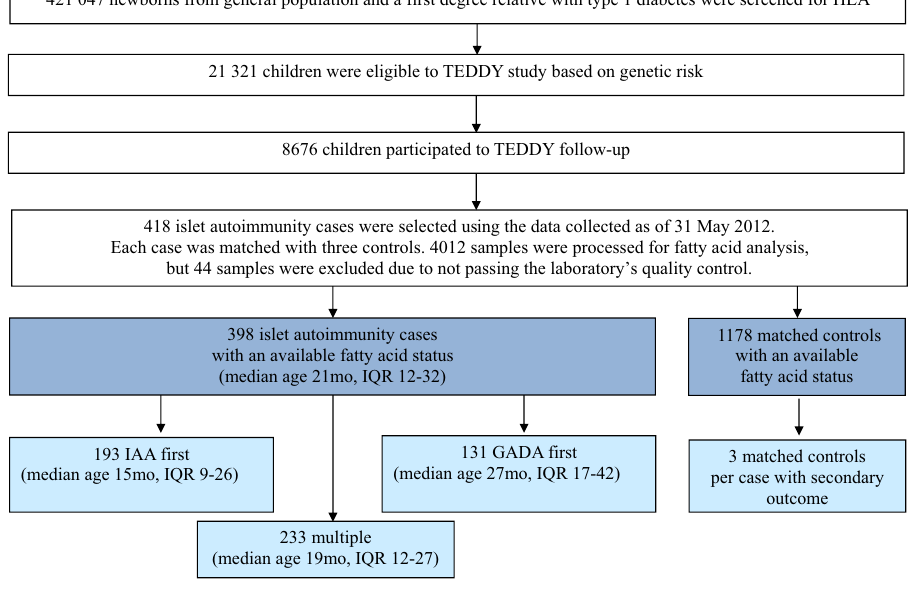
Figure 1. Flow chart of the study